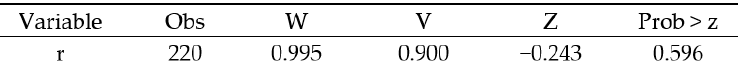
Figure 3. The results of Shapiro–Wilk W test.